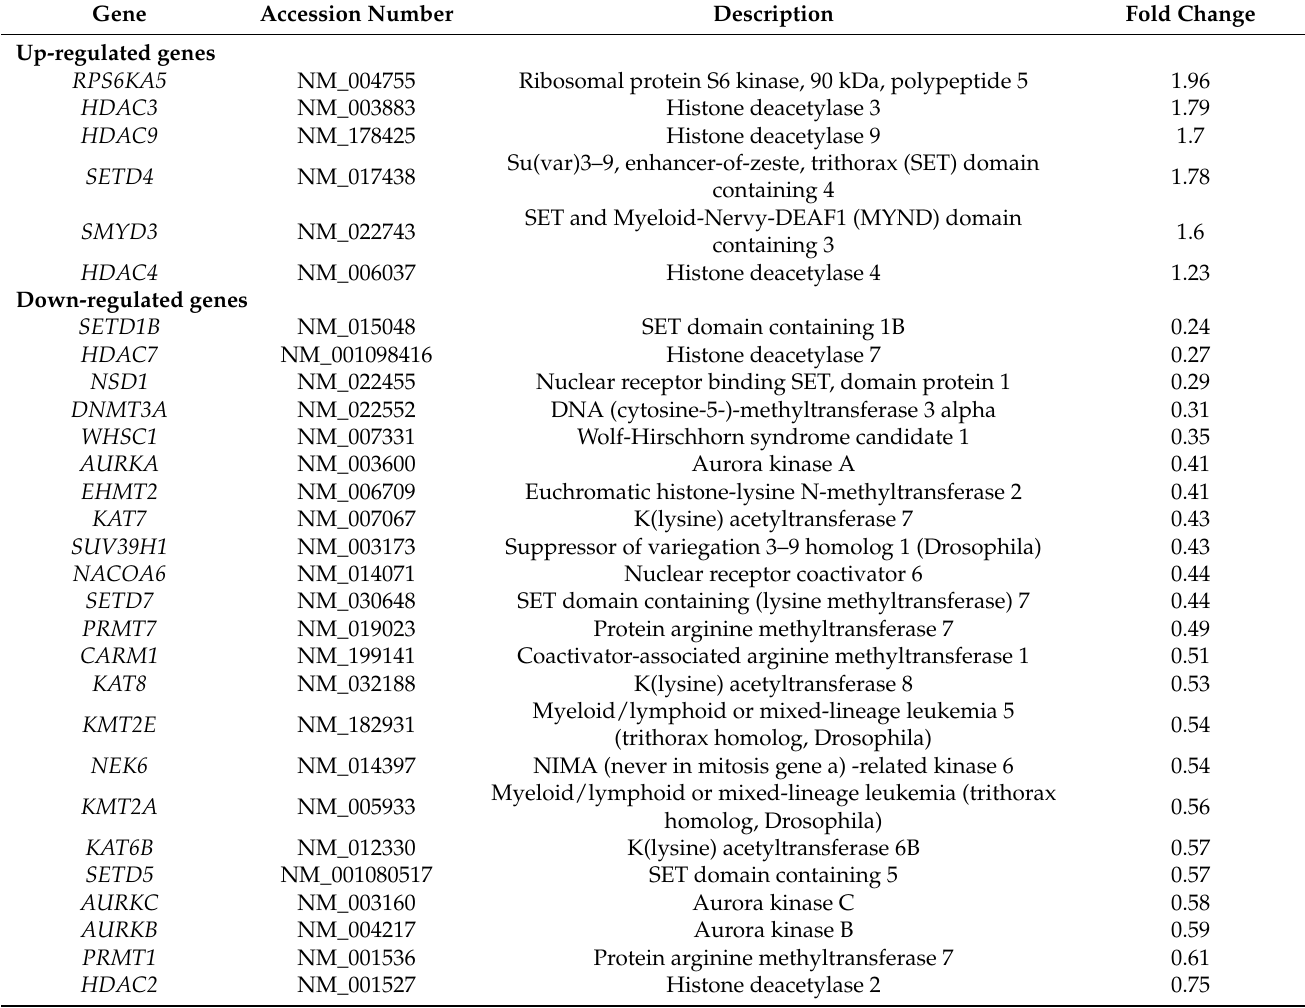
Table 1. List of selected up- and down-regulated genes modulated by suberoylanilide hydroxamic acid (SAHA) treatment in A2780 ovarian cancer cells analyzed using PCR